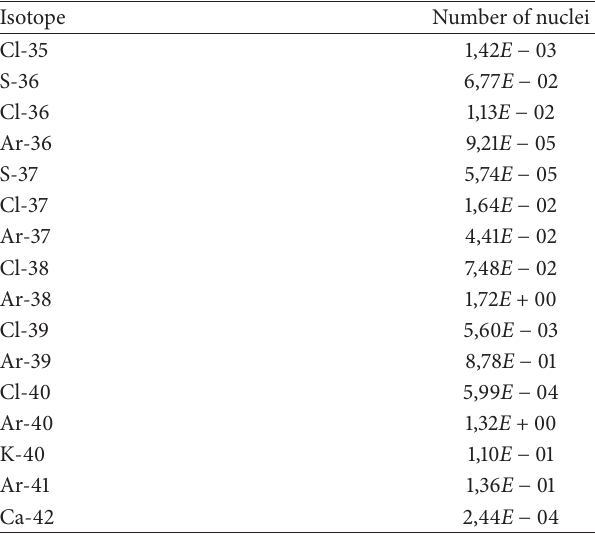
Table 1: Isotope distribution after interactions between CR and Earth’s